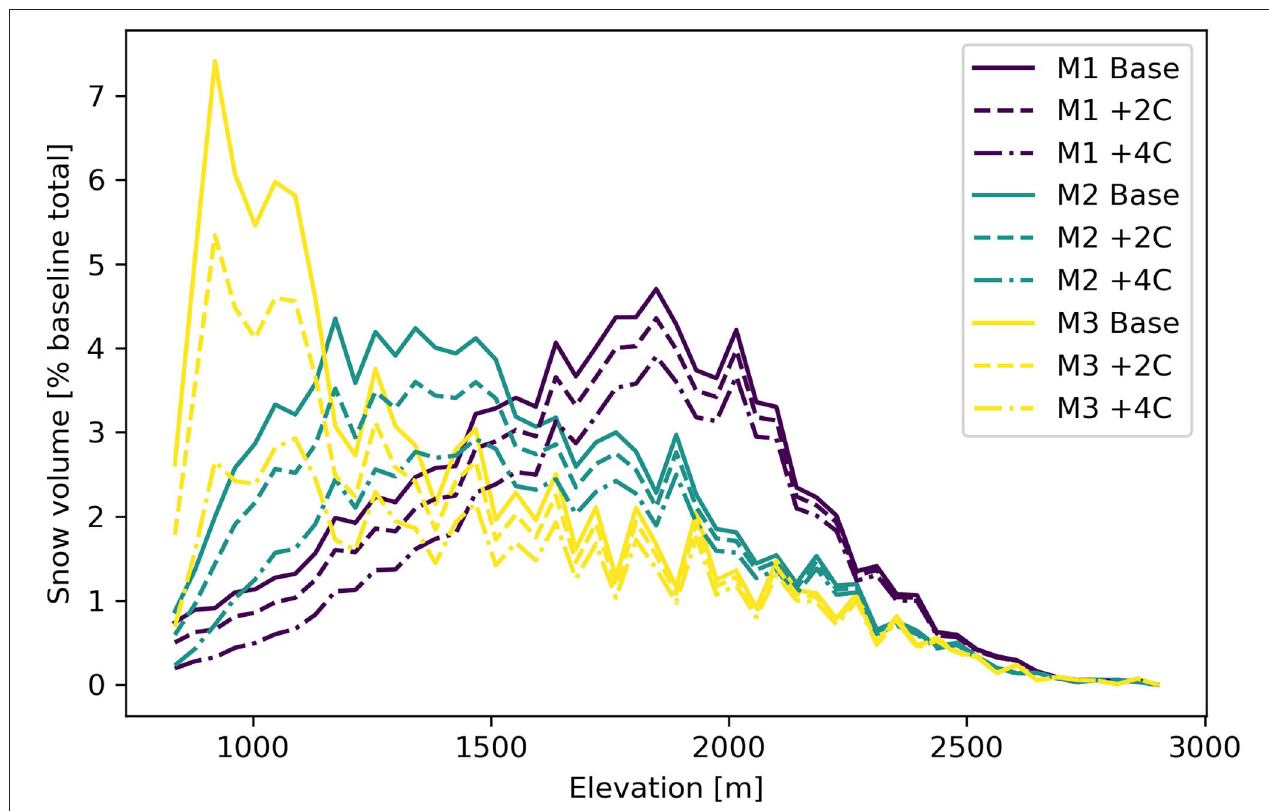
FIGURE 5 | Basin snow volume in each elevation band as a percentage of total snow volume from the baseline scenario for three hypsometry profiles ( Figure 2 ) and two temperature change scenarios.